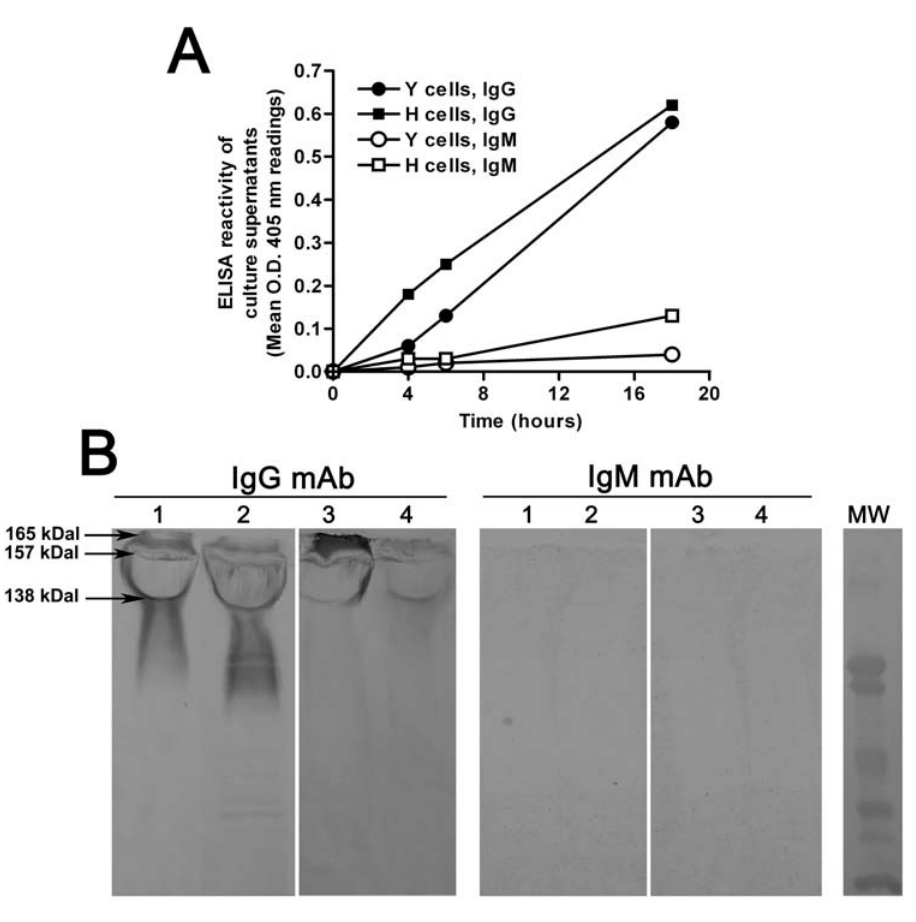
Figure 5. Reactivity of the anti- b -glucan mAbs to the secretory material and cell wall proteins of C.albicans . Panel A: Secretion of IgG- or IgM-reactive b -glucan material during fungal growth. Serial dilutions of fungal culture supernatants obtained at different times of growth in the yeast (Y) or hyphal (H) form were adsorbed (in duplicate) onto polystirene plates and reacted with the mAbs in ELISA. The figure shows reactivity of fungal supernatants diluted 1:100, as from one representative experiment out of two performed independently. Panel B: Western blot analysis of culture supernatants and cell wall proteins. Culture supernatants (lane 1, 50 m g and lane 2, 25 m g polysaccharide) and cell wall proteins (lane 3, SDS-extracted and lane 4 b 1,3-glucanase-extracted) were reacted with the anti- b -glucan mAbs, as indicated. Calculated molecular weight for IgG-reactive bands is also indicated. MW: molecular weight markers (104.3, 97.3, 50.4, 37.2, 29.2, 20.2 kDal).